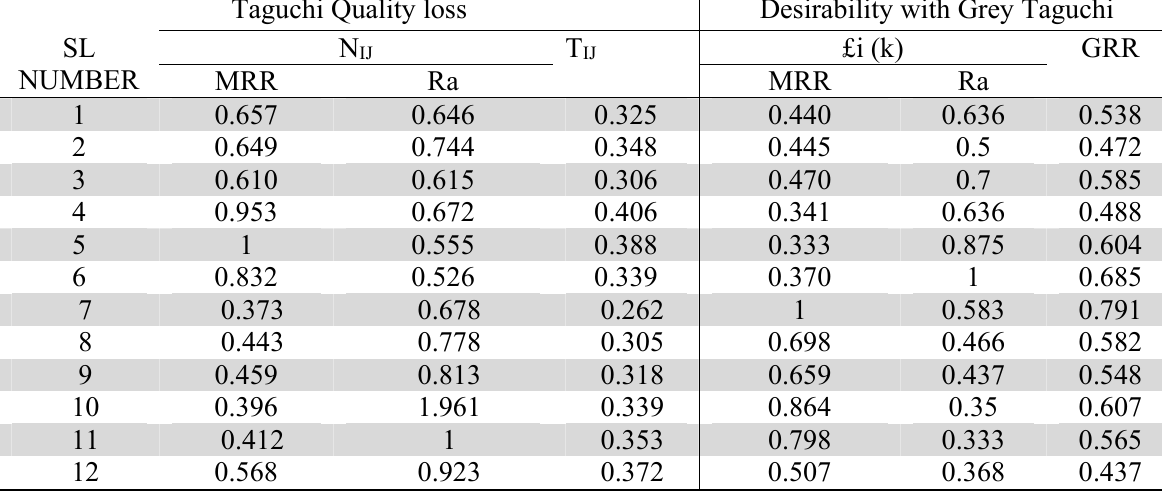
Comparision between Taguchi quality loss and Desirability with Grey Taguchi Taguchi Quality loss Desirability with Grey